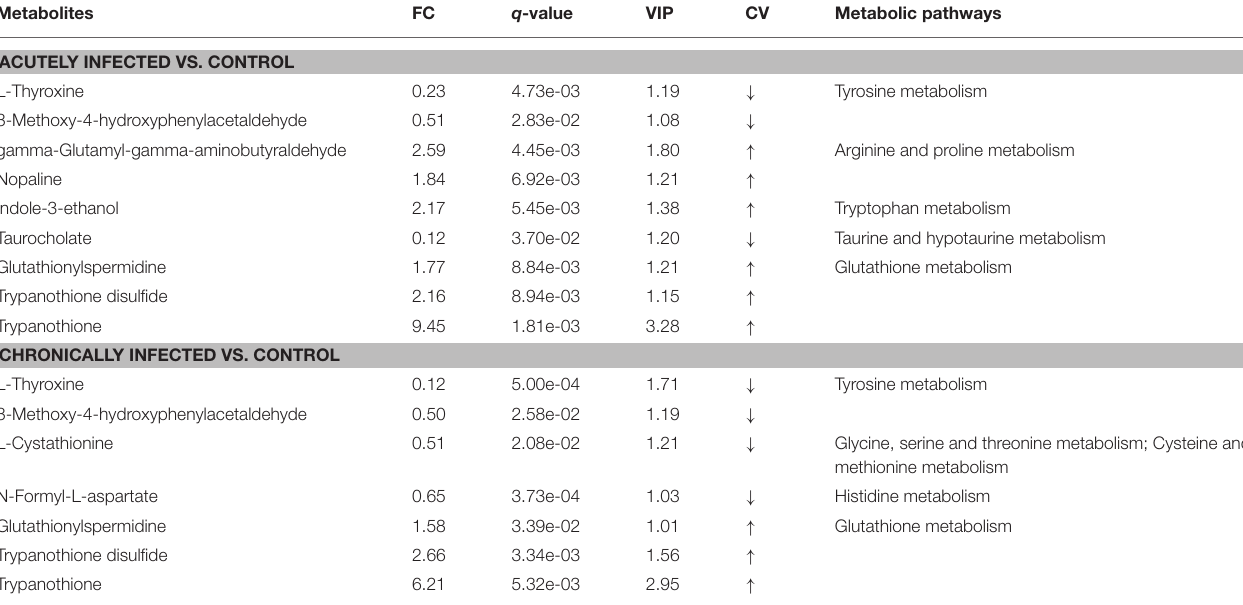
TABLE 2 | List of the differentially expressed metabolites involved in amino acid metabolism during the acute and chronic phases of Toxoplasma gondii infection. Metabolites FC q -value VIP CV Metabolic pathways